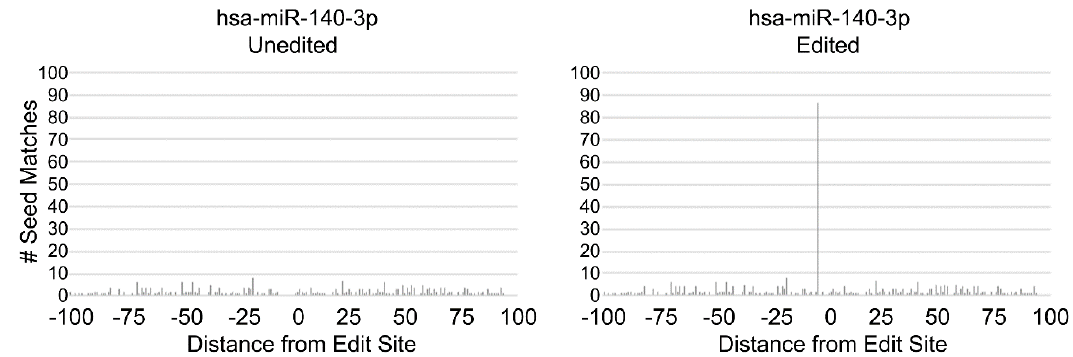
Figure 4. A-to-I edits create novel target sites for miR-140-3p. mRNA sequences from the edit sites previously identified [37] (each consisting of a central A-to-I deamination and 100 nt flanks) were screened for complementarity to human miRNAs. The graphs represent all miR-140-3p seed matches occurring at each possible position within both the unedited ( left ) and edited ( right ) states.